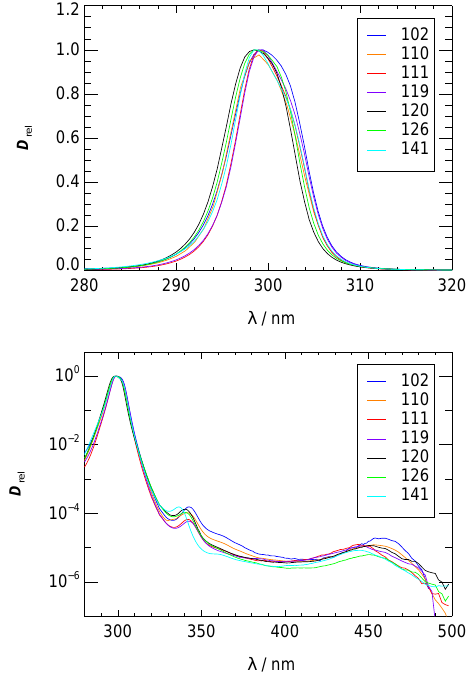
Figure 3. Relative spectral sensitivities D rel of seven j (O 1 D) fil- ter radiometers in their original setup. The upper panel shows the main sensitivity peaks on a linear scale. The lower panel depicts an extended wavelength range in a semi-logarithmic plot indicating a residual sensitivity around 10 − 5 above 350nm.